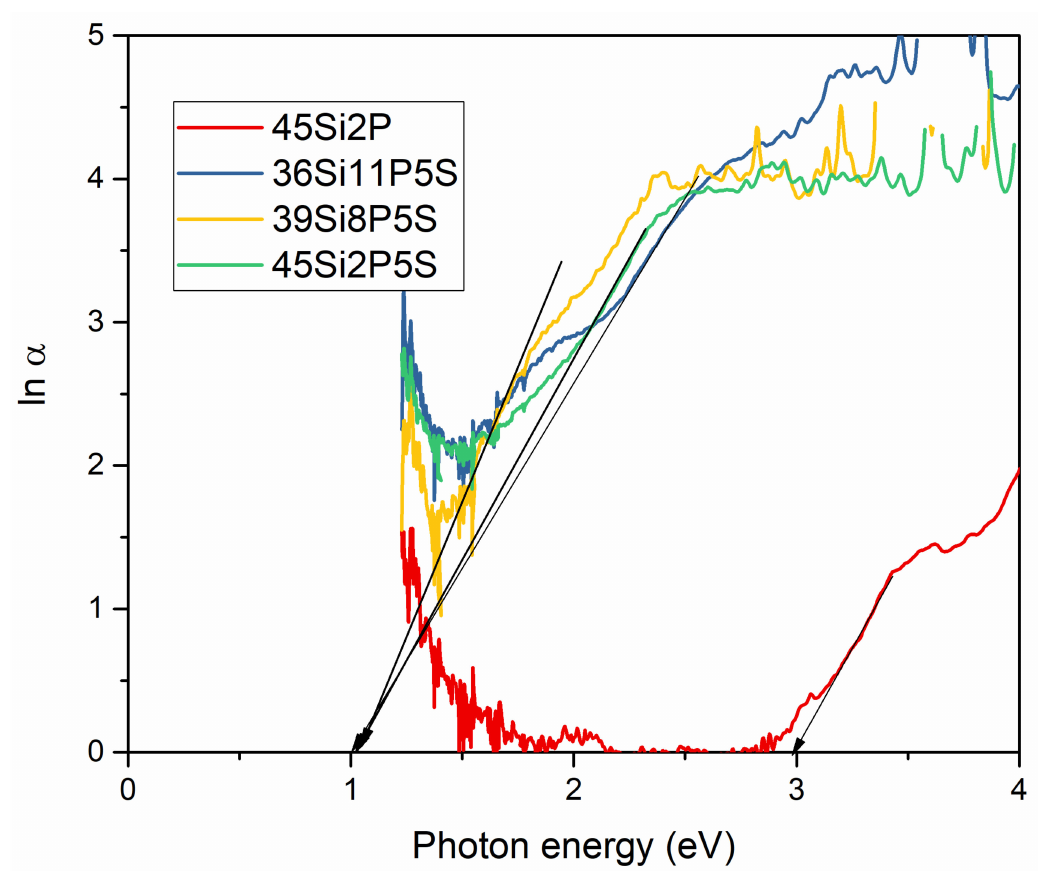
Figure 14. Urbach plot for the silicate–phosphate glass samples: 36Si11P5S, 39Si8P5S, 45Si2P5S, and